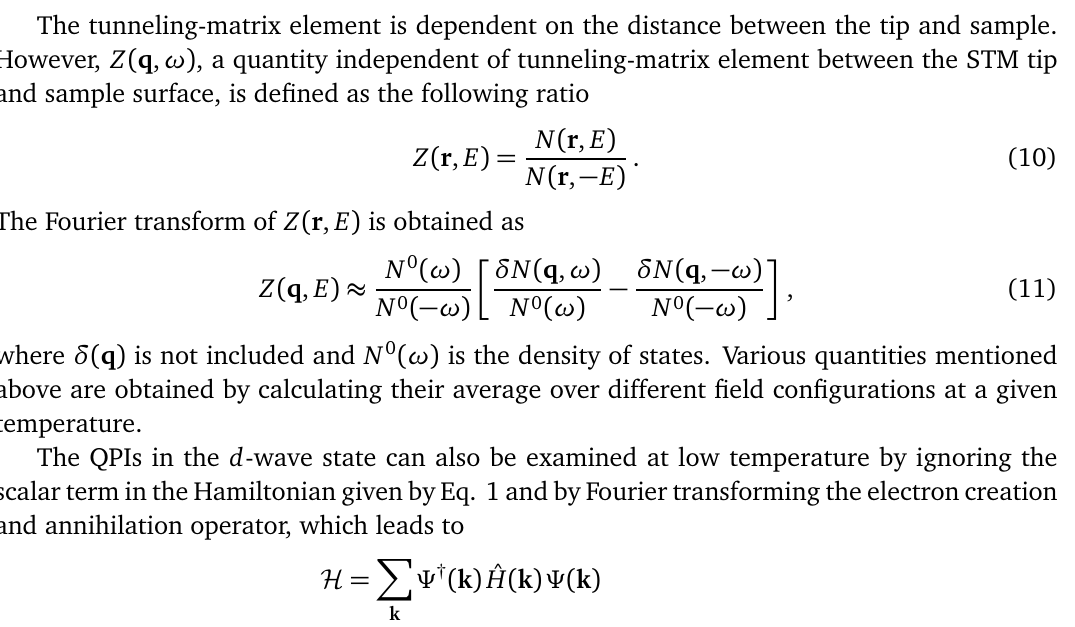
Figure 1: (a-c) The CECs for the quasiparticle energies in steps of 0.4 ∆ range 0 ≤ ω ≤ ∆ . The banana-shaped CECs can be seen to exist up to ∆ o g -maps and (g-i) z -maps for various quasiparticle energies in similar steps when a non-magnetic impurity is present. The QPI patterns are dominated by the scattering vectors q , q , q , and q . There is no significant difference between the two sets of 2 3 6 7